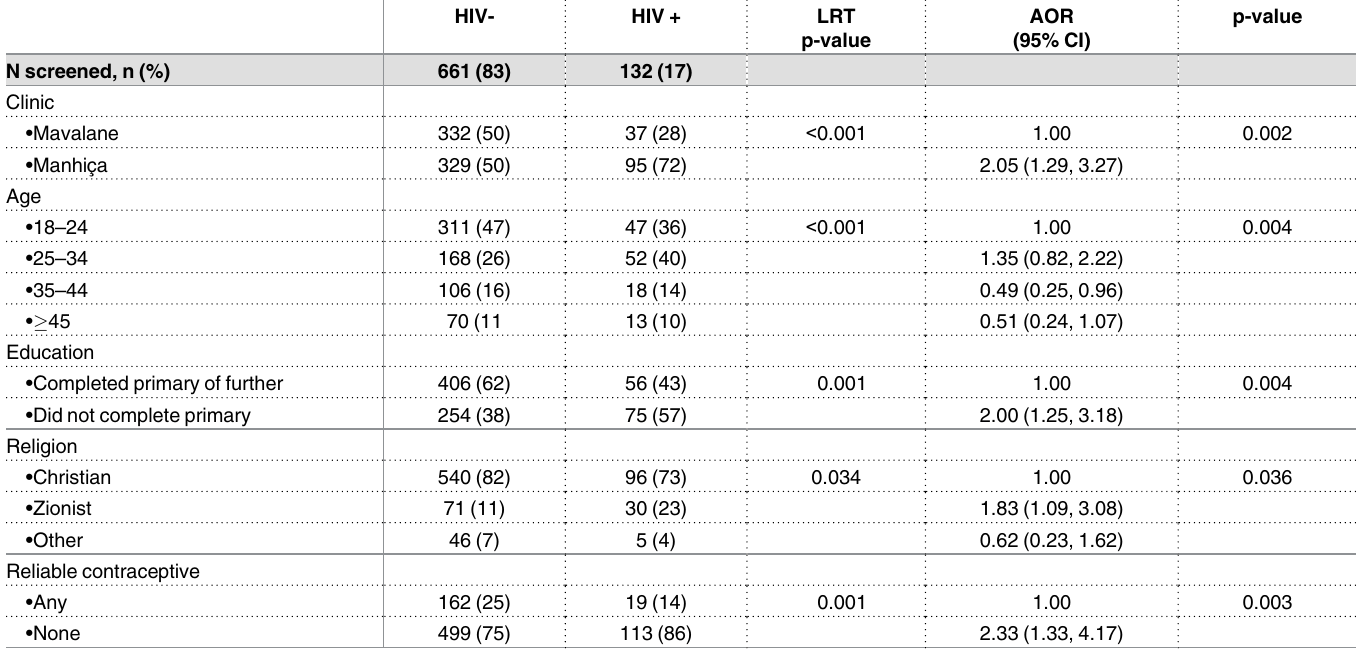
Table 2. Multivariate model assessing characteristics of HIV positive women at